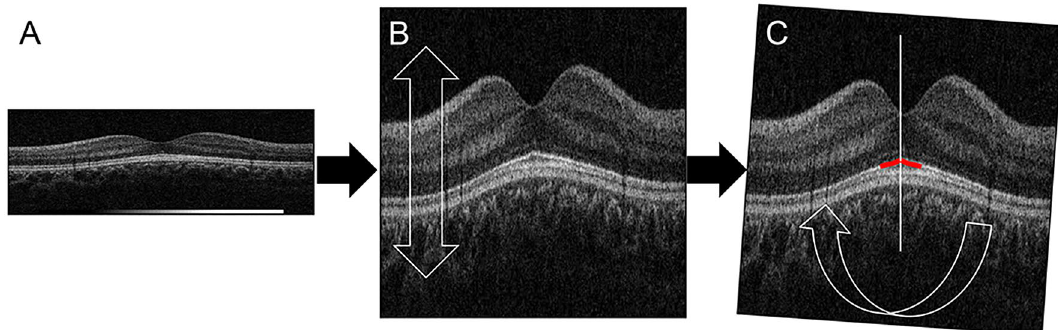
Figure 1. Magnification of the optical coherence tomographic (OCT) vertical cross-sectional image. First, the original 2X B-scan image ( A ) was vertically expanded 4X ( B , vertical-to-horizontal ratio, 8:1) for easier detection of the macular shape. Second, the image was rotated to make the ellipsoid zone around the fovea symmetrical ( C ).